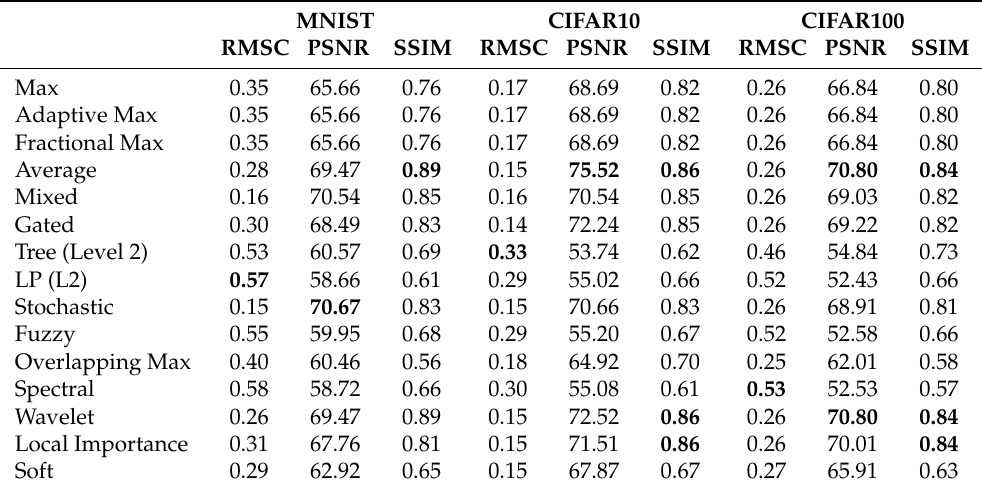
Table 4. The details’ retention indicators of our benchmark. The best value for each metric in each separate dataset is